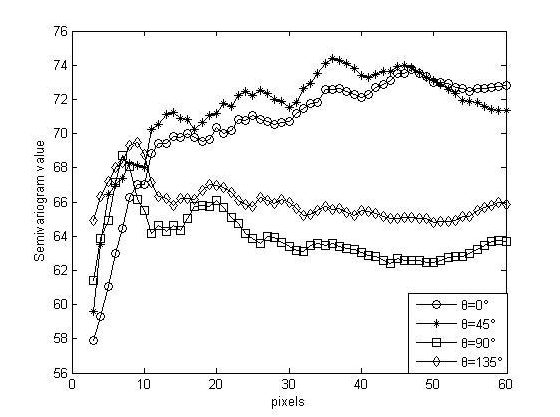
Figure 1. Semi-variogram of water sample in different